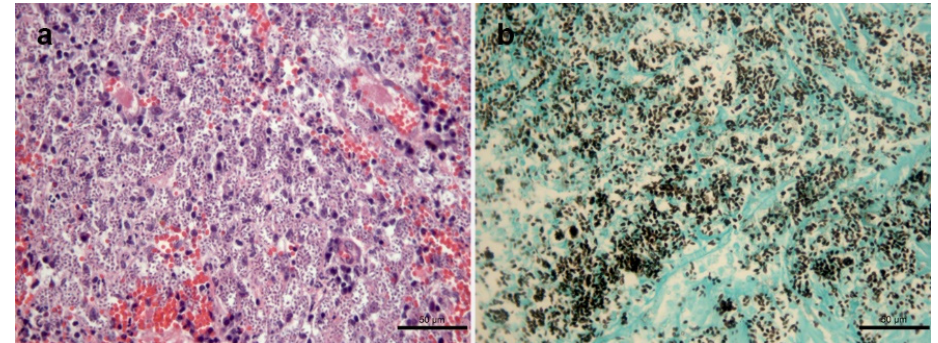
Figure 2. Histological changes in the skin lesion of a cat with sporotrichosis caused by Sporothrix brasiliensis . ( a ) Granulomatous dermatitis exhibiting abundant yeasts inside macrophages, lympho- cytes and plasma cells and vascular congestion. Hematoxylin and eosin. ( b ) Abundant black-stained round or cigar-shaped yeasts. Grocott’s methenamine silver stain.